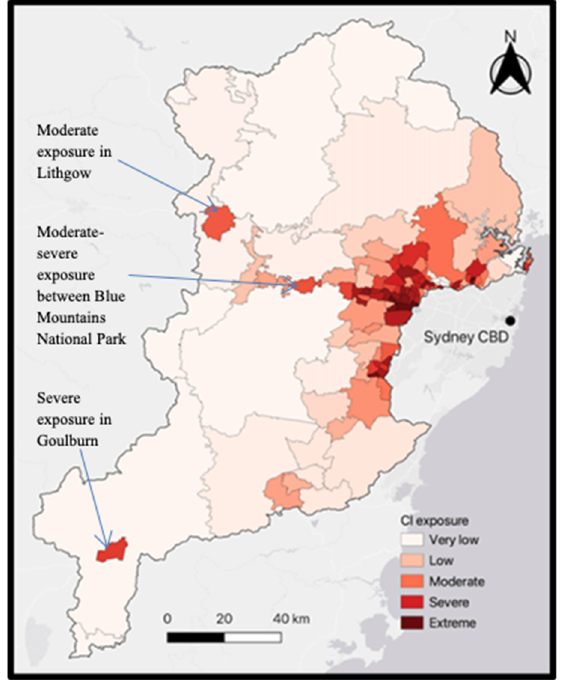
Figure 4. Map of critical infrastructure (CI) flood exposure in the HNC (at SA2), after fuzzy standardisation (QGIS 3.24).